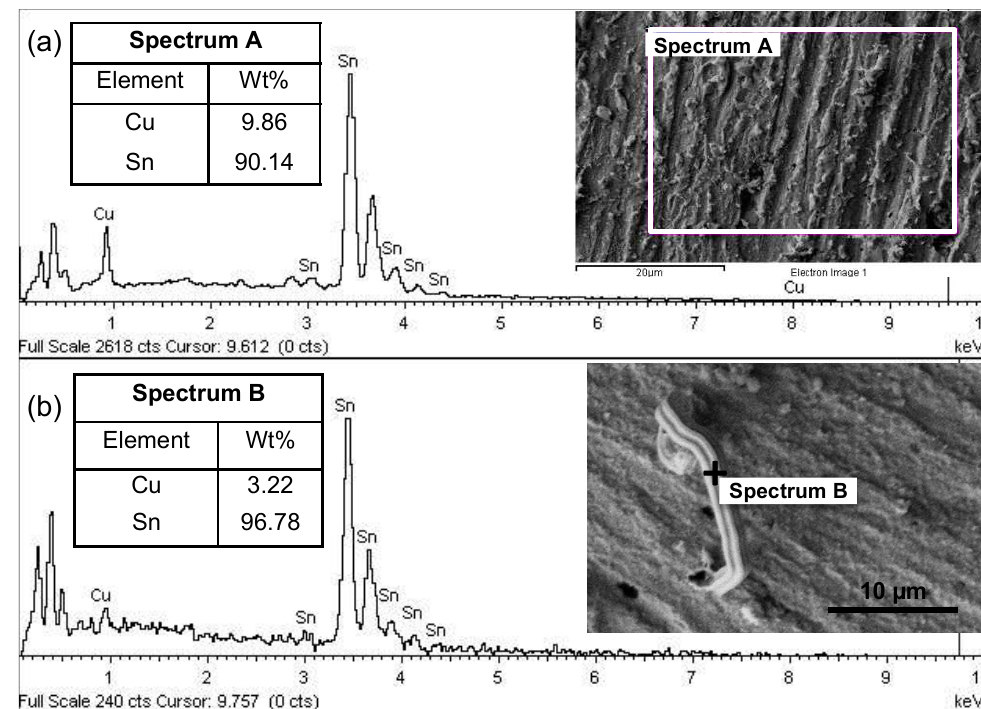
Figure 2. EDX spectra of the selected area in the FESEM micrograph of the immersion tin surface finish ( a ) and point analysis on selected tin whiskers’ surface ( b ). The inserted table shows the chemical composition of the measured surfaces. The inserted image is the FESEM micrograph of the measured surfaces.